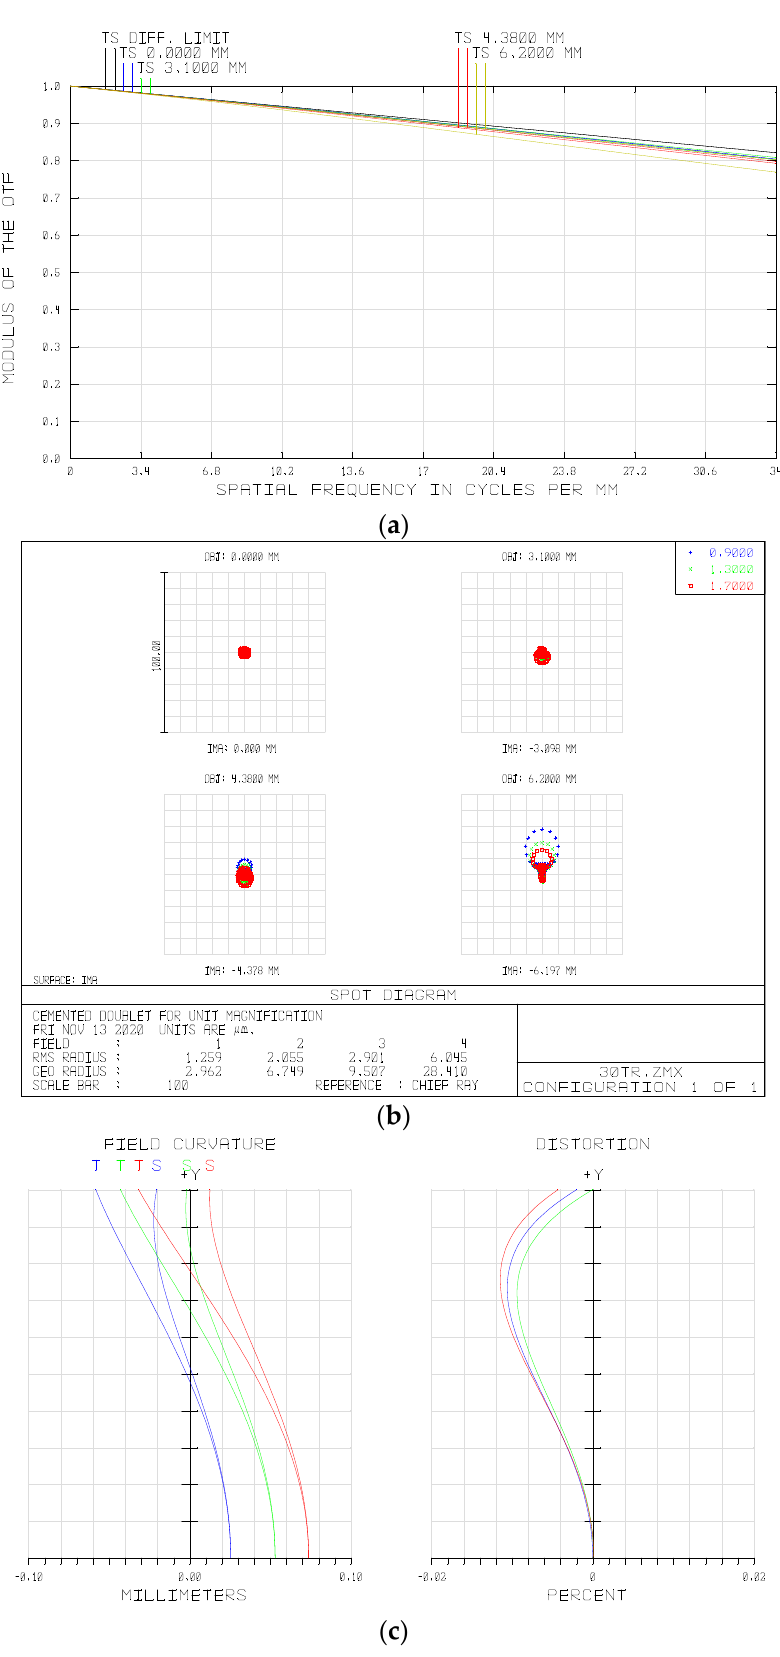
Figure 9. Optical performances of the relay lens: ( a ) MTF of the system, ( b ) spot diagram, and ( c ) field curvatures and distortions of different wavelengths.